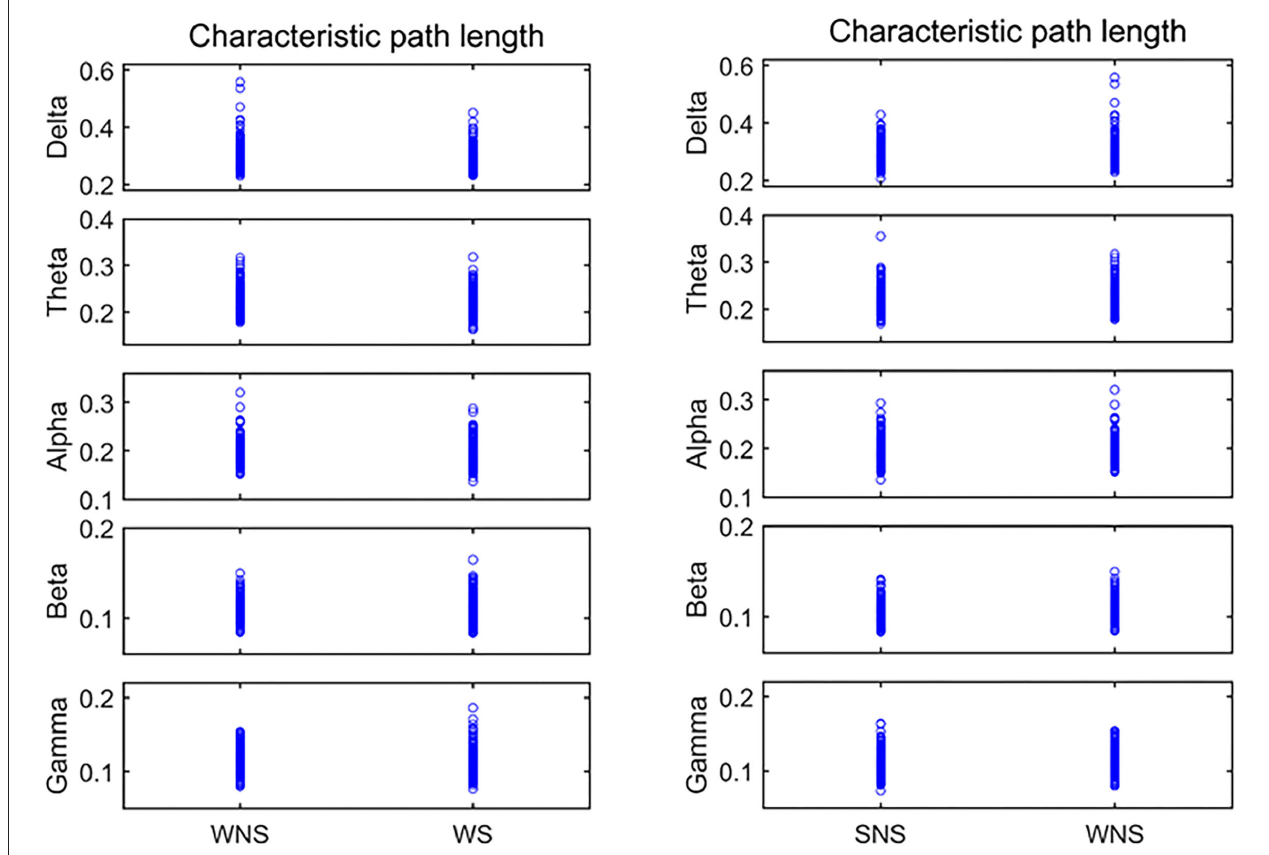
FIGURE 2 | Characteristic path length (CPL) in different frequency bands. Two-sided non-parametric Wilcoxon rank-sum tests were taken. The delta, alpha, and beta frequencies became shorter when comparing the ictal and interictal phases, and the alpha band expanded when comparing the waking and sleep phases ( P < 0.05). SNS, sleep period; WNS, awake period; WS, ictal period during